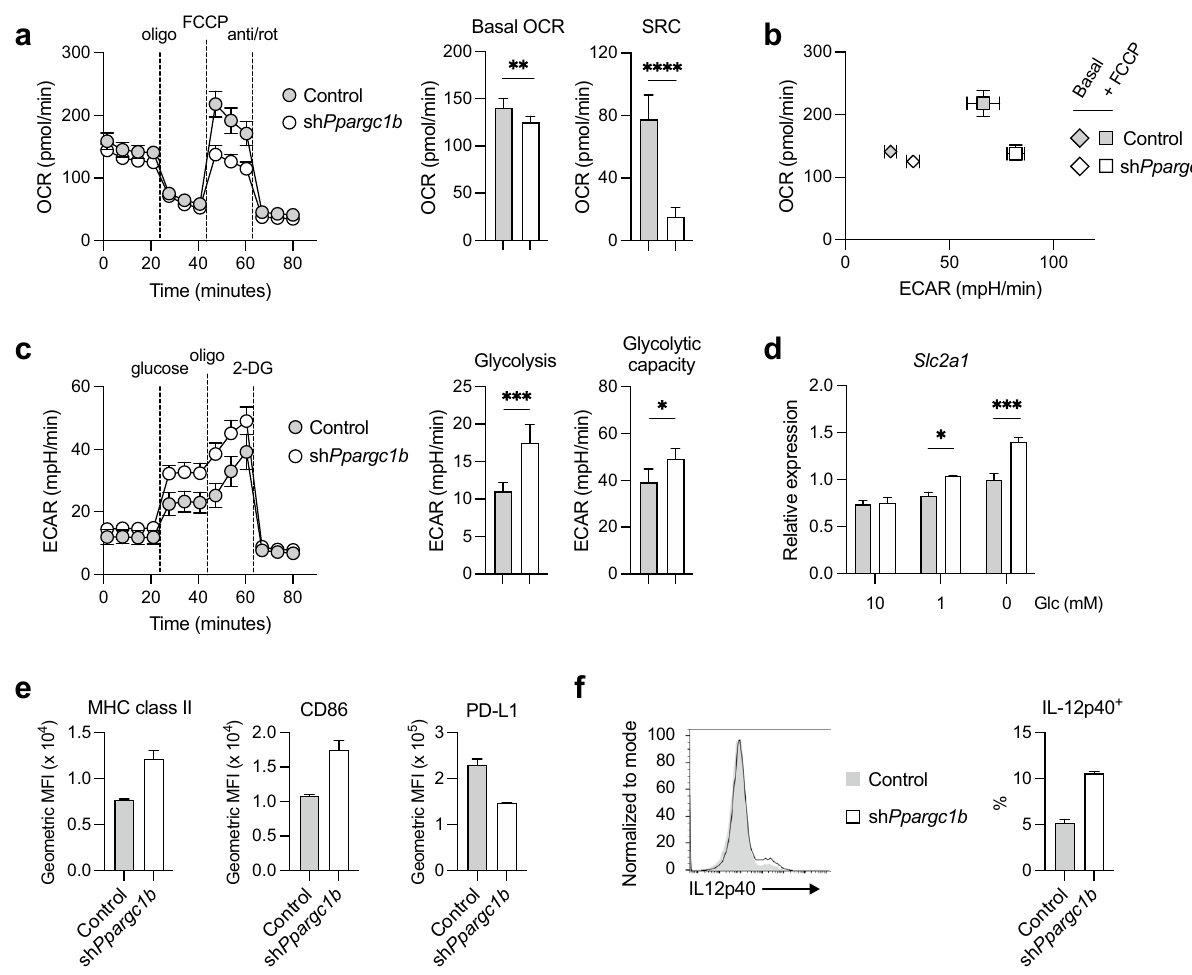
Figure 2. PGC-1β-deficient DCs have impaired oxidative metabolism and increased glycolysis. DCs were transduced with control shRNA or Ppargc1b shRNA and ( a ) OCR was measured by Seahorse bioanalyzer over time with sequential treatments with oligomycin (oligo), FCCP, and antimycin and rotenone (anti/rot). Basal oxygen consumption rate (OCR) and spare respiratory capacity (SRC) were determined from these measurements (right). ( b ) Basal and maximal (with FCCP) levels of OCR and ECAR from experiment in ( a ). ( c ) ECAR was measured over time with sequential treatments with glucose, oligomycin, and 2-deoxyglucose (2-DG). From this graph (left), glycolysis (difference between ECAR after glucose addition and non-glycolytic ECAR before glucose addition) and glycolytic capacity (maximal ECAR after oligomycin treatment) were determined. ( d ) Gene expression of GLUT1 gene Slc2a1 relative to Hprt levels in DCs cultured in 10, 1, or 0 mM glucose for 6 h. ( e ) Geometric MFI of MHC class II, CD86, and PD-L1, and ( f ) intracellular levels of cytokine IL-12p40 (histogram on left; IL-12p40 + cells expressed as a percentage of transduced CD11c + DCs on right) were determine by flow cytometry. Data are of one experiment representative of ( a , b ) five experiments, ( c ) three experiments (mean and s.d. of five to six replicates per condition), ( d ) two experiments (mean and s.e.m. of triplicates), and ( e , f ) three experiments (mean and s.d. of duplicates). Statistical significance was determined by ( a , c ) unpaired t-test or ( d ) two-way ANOVA. * p < 0.05, ** p < 0.01, *** p < 0.001, **** p < levels of MHC class II, a molecule for antigen presentation, and CD86, a co-stimulatory molecule, and reduced levels of PD-L1, an immunomodulatory ligand, compared to control DCs (Fig. 2e). In addition, at both steady state and with IFN-β treatment, PGC-1β-deficient DCs express higher levels of the pro-inflammatory cytokine IL-12p40 (Fig. 2f; Supplementary Fig. S3a). However, expression of CCR7, a chemokine receptor essential for directional DC migration typically elevated with activation 19 , is generally reduced with PGC-1β deficiency (Supplementary Fig. S3b). Further, intracellular IL-6 expression in DCs at steady state or with IFN-β treatment was not altered by PGC-1β loss (Supplementary Fig. S3c), suggesting that not all pro-inflammatory markers are elevated. Thus, PGC-1β deficiency leads to a selective increase in activation marks in steady-state DCs and IFN-β-treated DCs.